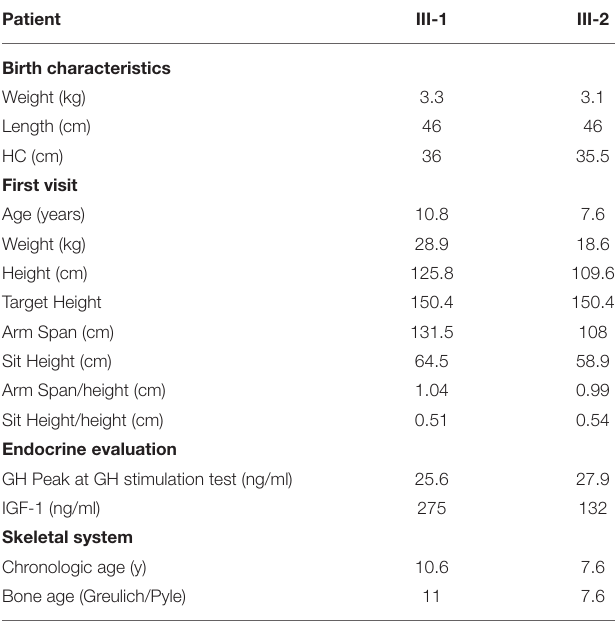
TABLE 1 | Phenotype of our two patients with ACAN